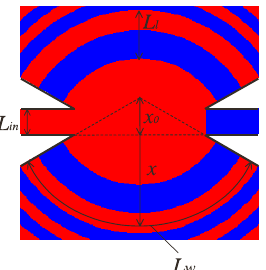
Fig. 12 Layered flow pattern model in an asterisk-shaped channel.